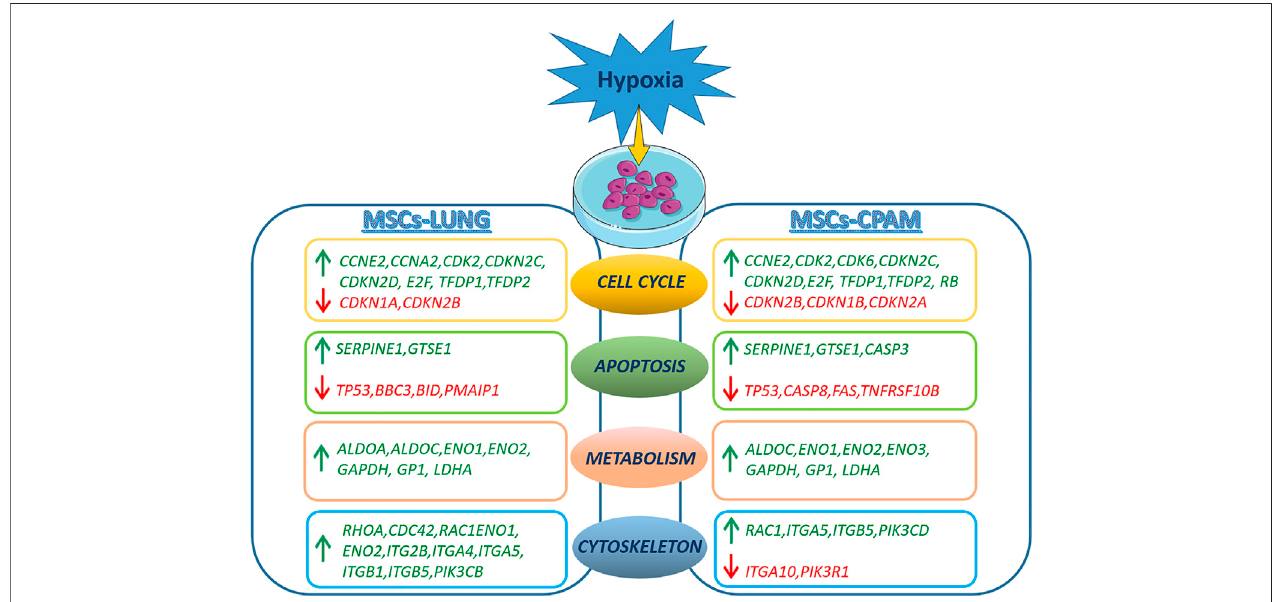
FIGURE6| RepresentationofDEGsobservedintheMSCs-lungorMSCs-CPAMinhypoxiacondition.The fi gurewasmadetakingtheimagesfromServierMedical Art (available at http://smart.servier.com/accessed on 20 January 2022), licensed under a Creative Commons Attribution 3.0 Unported License (https:// creativecommons.org/licenses/by/3.0/accessed on 20 January